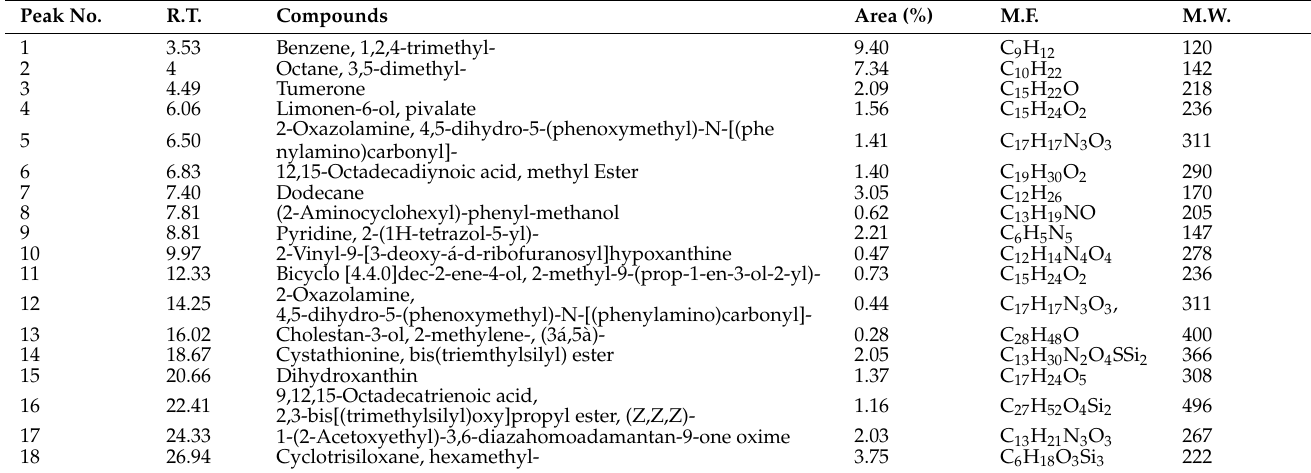
Table 6. Chemical composition of the methanolic extract of Withania somnifera roots.